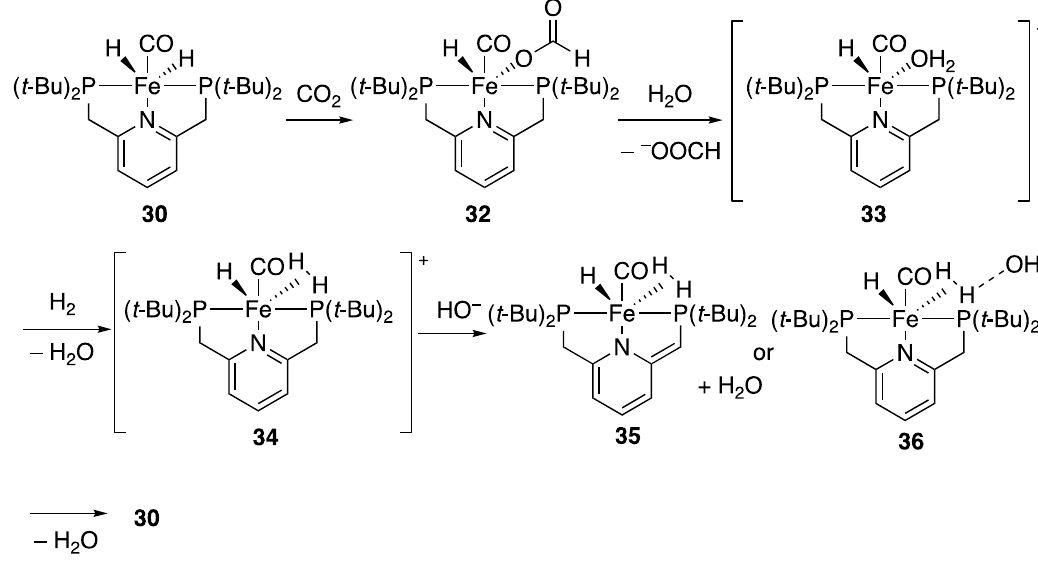
Scheme 17. Plausible mechanism for Fe-pincer complex-catalyzed hydrogenation of CO 2 to formate. Kirchner and Gonsalvi et al. reported a Mn-PNP pincer complex for the catalytic hydrogenation of CO 2 to formate [107]. Biscarbonyl monohydride complex 37 reacted immediately with 1 atm CO